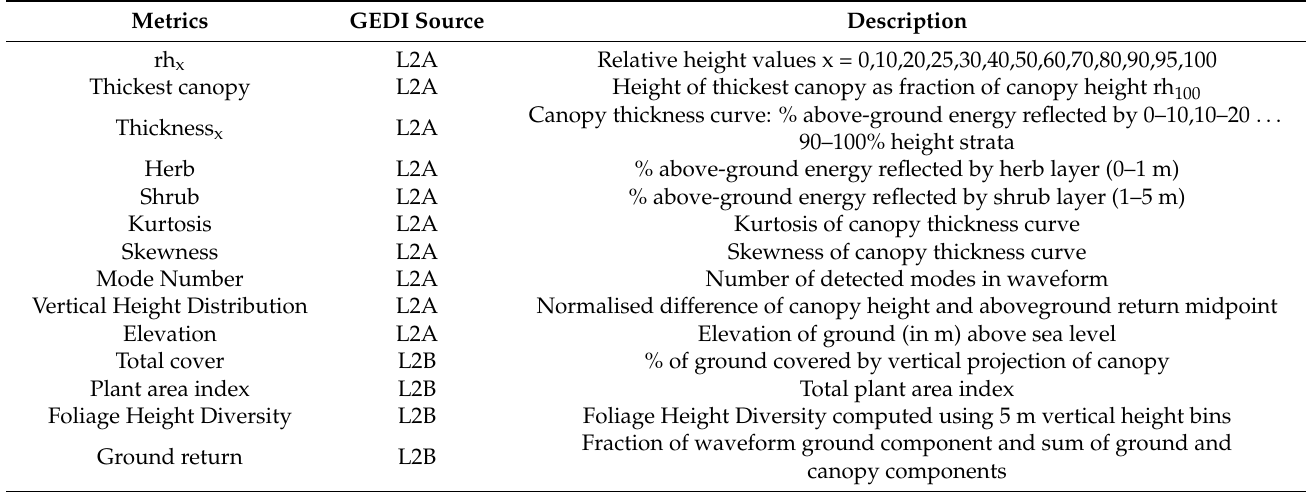
Table 1. Metrics used in the